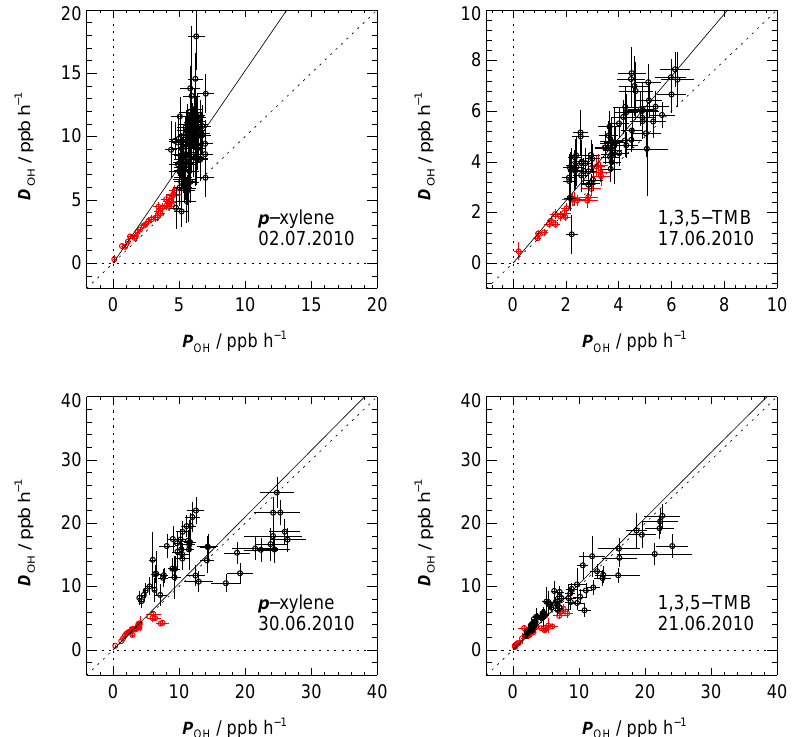
Figure 4. Correlation of OH destruction rates ( D OH ) and production rates ( P OH ) for SAPHIR experiments in 2010 under low-NO conditions (upper panels) and high-NO conditions (lower panels). Black and red data points indicate different periods of the experiments. Red: zero air period; Black: after the injection of aromatics. The solid lines correspond to the mean ratios listed in the third column of Table 3 ( P OH calculated by Eq. 2), dashed lines are 1:1